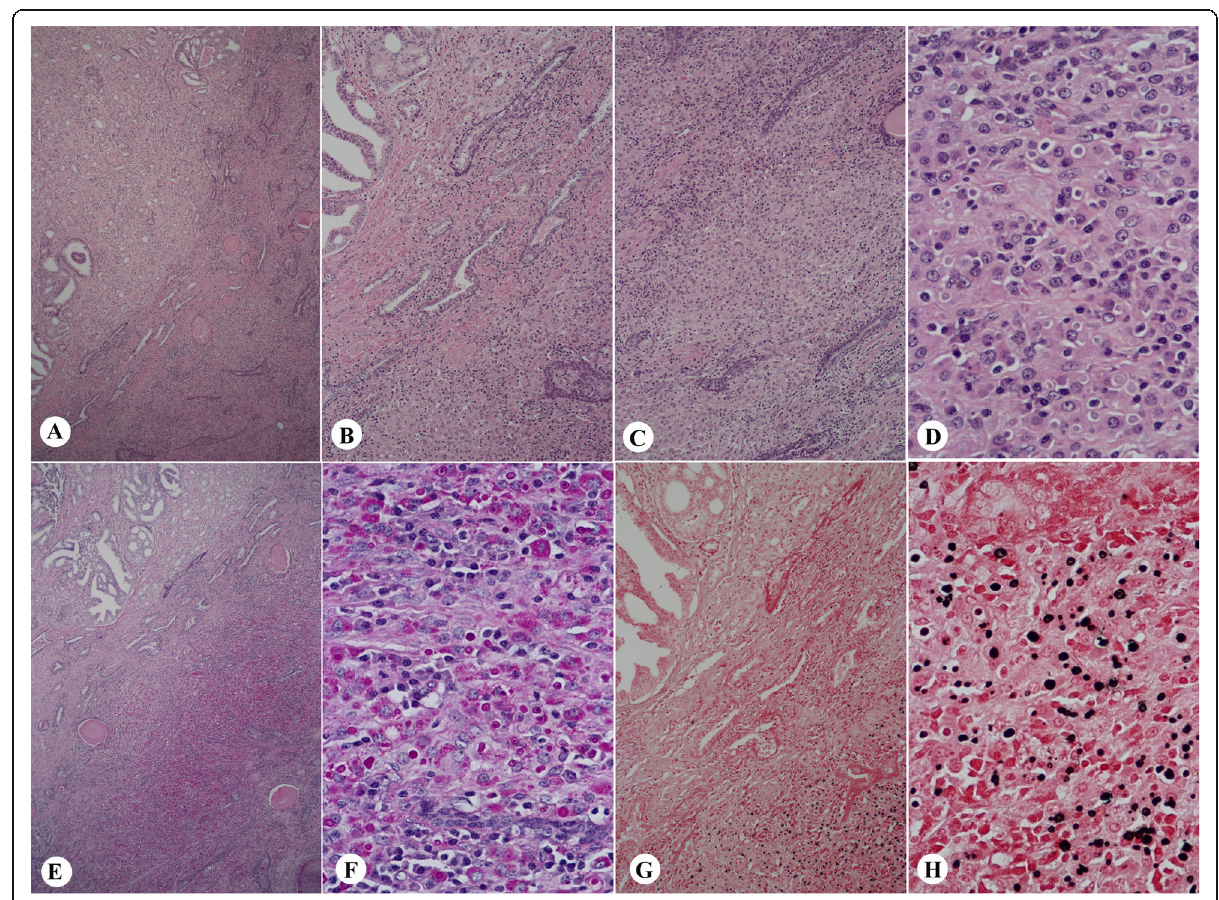
Fig. 2 Case 2. Prostatic adenocarcinoma associated with malakoplakia. A high-grade adenocarcinoma with cribriform morphology merging a solid lesion (HE stain: a 40x and b 100x). Malakoplakia area shows dense histiocytic infiltrate intermixed with benign glands ( c HE, 100x). Round basophilic inclusions are readily identified in HE stain within the cytoplasm of histiocytes ( d HE, 400x). PAS stain in the transition zone highlights strong staining in malakoplakia (PAS – e 100x and f 400x). Round inclusions (Michaelis – Gutmann bodies) are strongly positive by von Kossa stain (von Kossa: g 100x and h